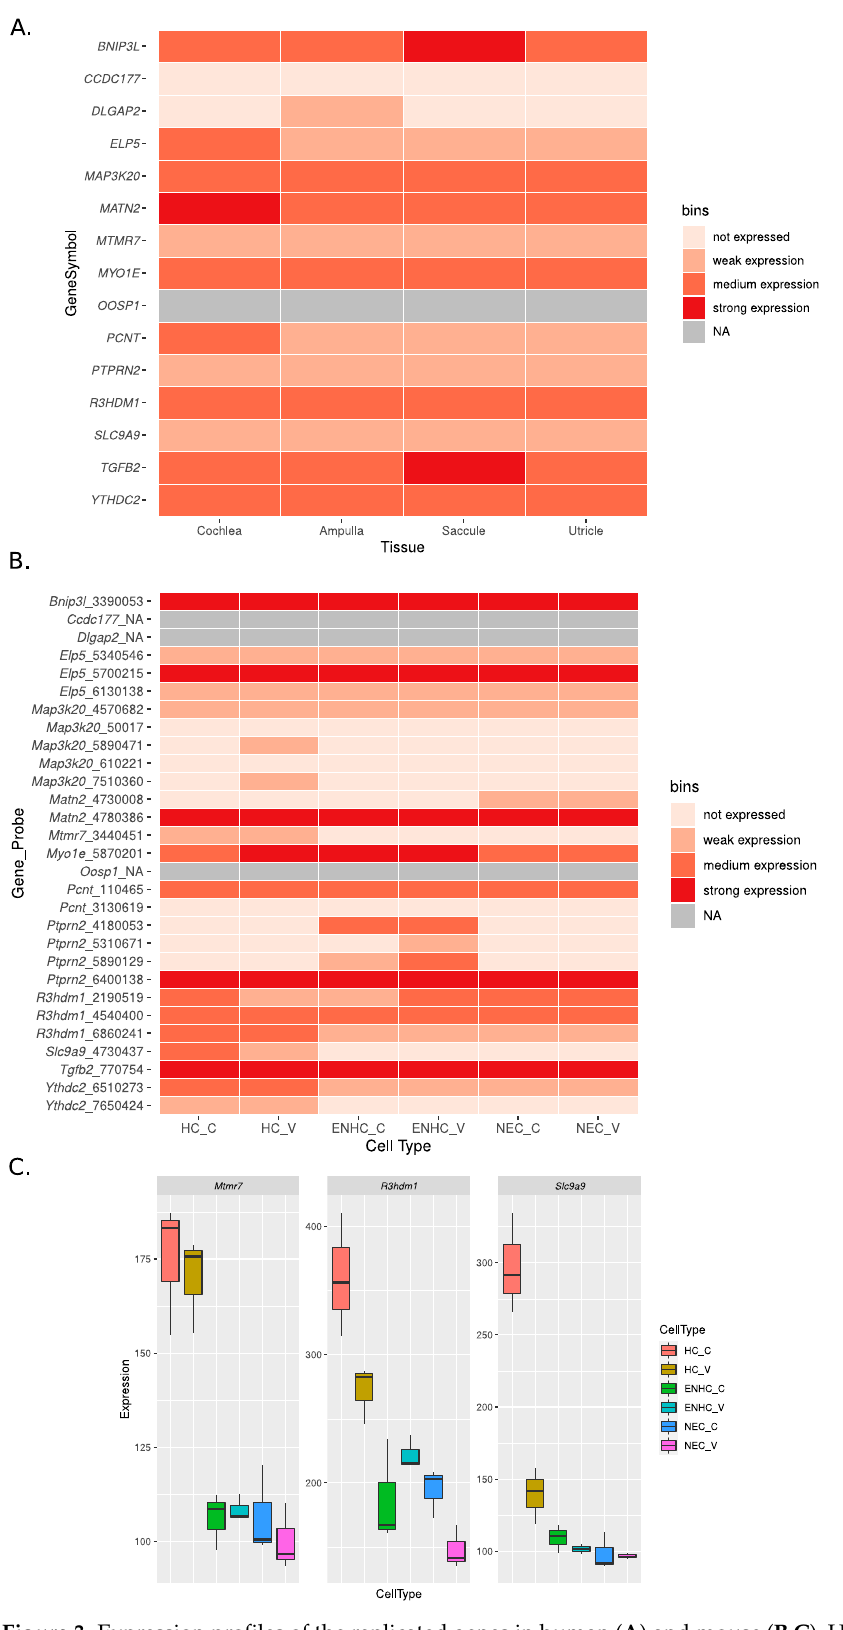
Figure 3. Expression profiles of the replicated genes in human ( A ) and mouse ( B , C ). Human cochlea expression represents the mean across the three replicates. In panel ( A , B ), for readability, expression was categorized into “expression strength” bins. For human data (panel A, RNA-seq), we defined weak expression for values between 1 and 10 FPKM, medium